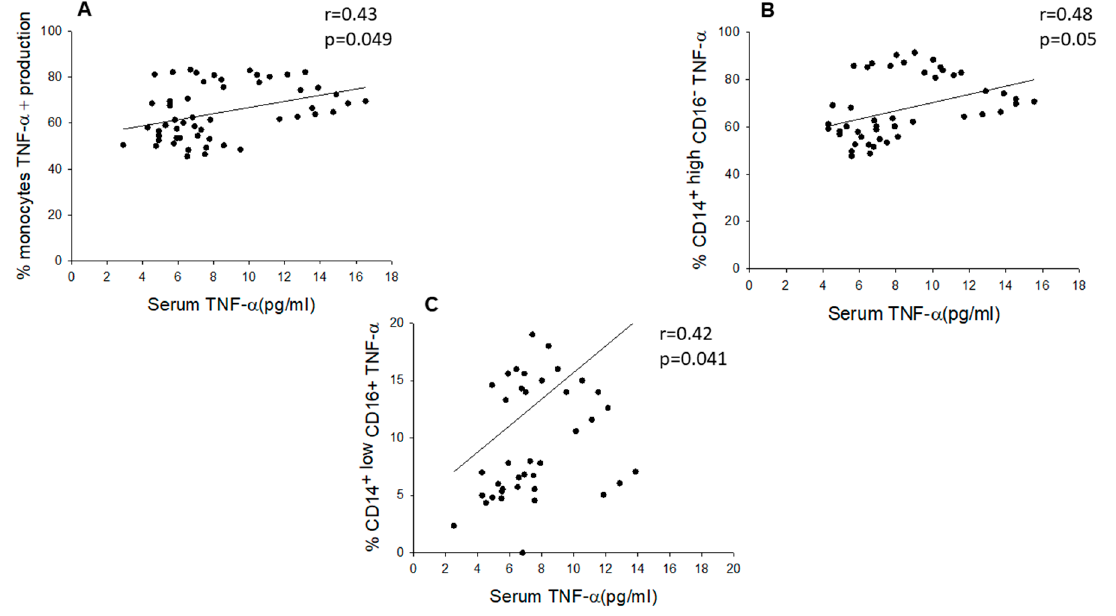
Figure 5. Serum TNF ‐α levels directly correlates with LPS ‐ induced TNF ‐α production in monocytes their Figure 5. Serum TNF- α levels directly correlates with LPS-induced TNF- α production in monocytes their CD14+highCD16- CD14+highCD16 ‐ and CD14+lowCD16+ subsets. Correlations between serum TNF ‐α levels and monocytes ( A ), and CD14+lowCD16+ subsets. Correlations between serum TNF- α levels and monocytes ( A ), CD14+highCD16- ( B ) and CD14+highCD16 ‐ ( B ) and CD14+lowCD16+ ( C ) subsets are shown. CD14+lowCD16+ ( C ) subsets are